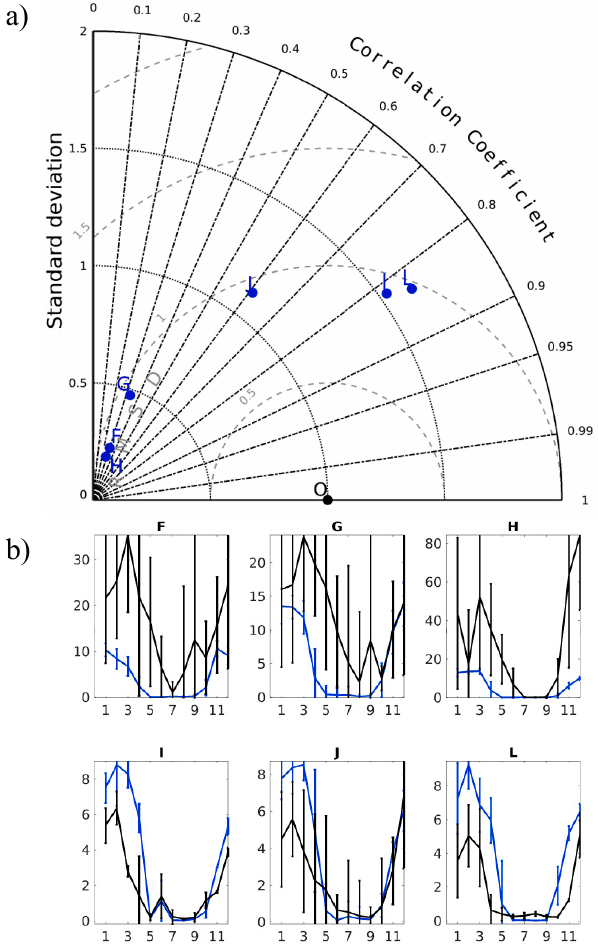
Figure 4. Validation of 2006 surface nitrate (model (blue) versus ICES data (black) (www.ices.dk)). Taylor diagram ( a ) and seasonal cycle ( b ) in different sub areas of the North Sea. Area separation according to Figure 1 insert.